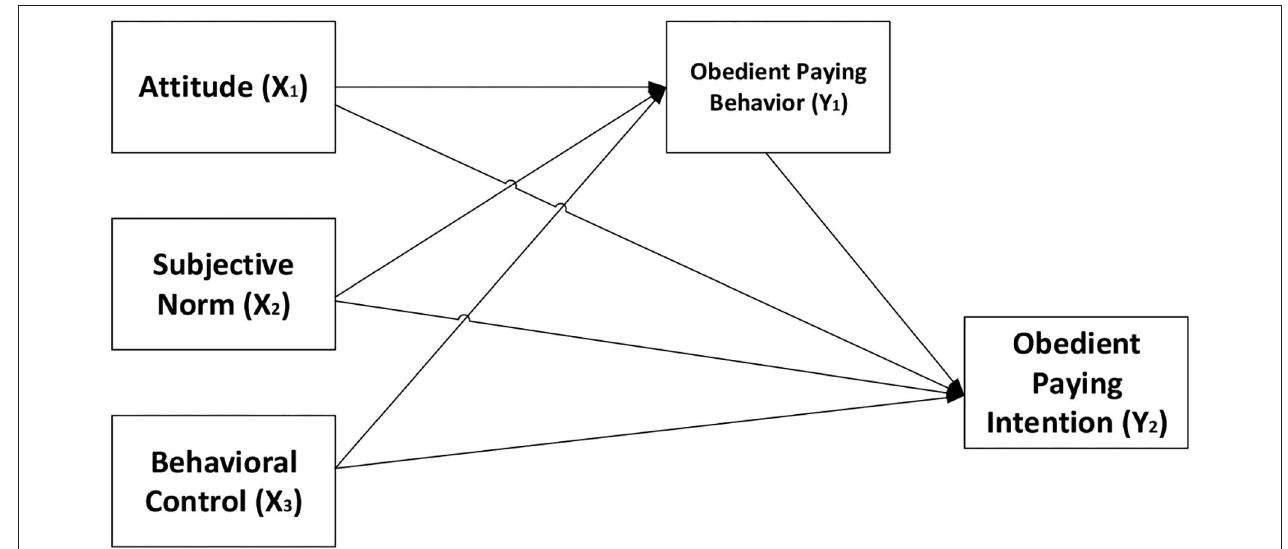
FIGURE 2 | Research path